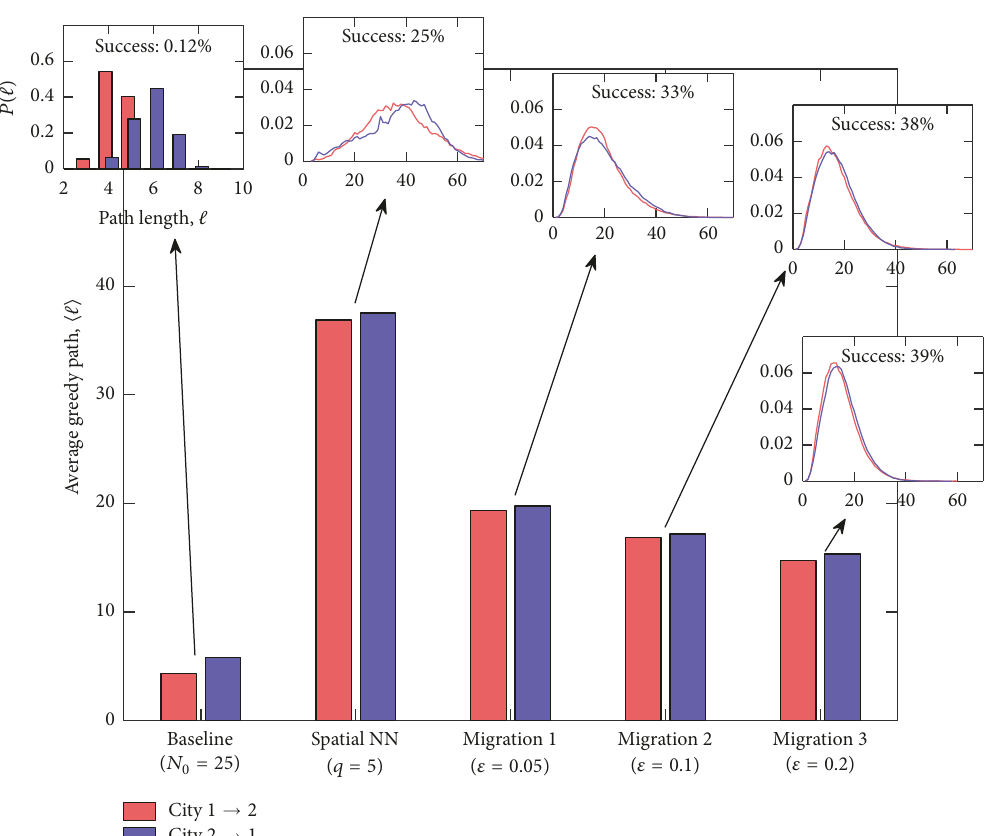
Figure 5: Statistics of greedy path length obtained by randomly sampling 5 × 10 5 node pairs (𝑖,𝑗) where 𝑖 and 𝑗 belong to the cities 1 and 2, see Figure 2(b). In the baseline model there are very few short, greedy paths. Connecting to closest neighbors increases the success rate significantly, but the paths found are quite longer. Even a tiny percentage of relocations not only further increases the success rate, but also reduces the greedy path length